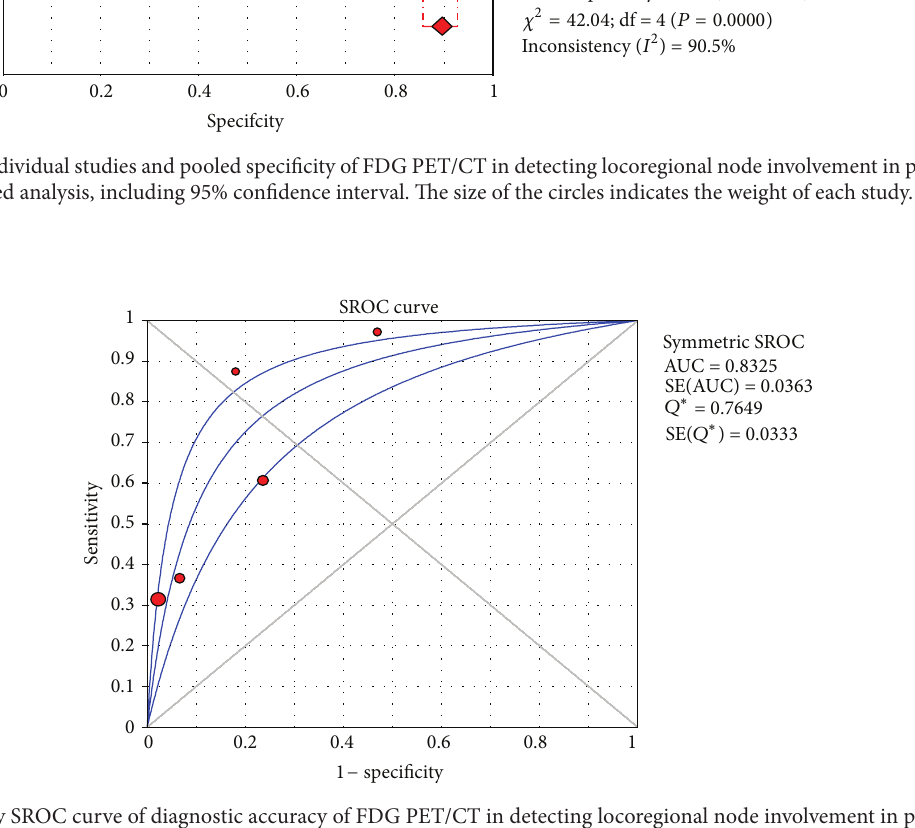
Figure 4: Summary SROC curve of diagnostic accuracy of FDG PET/CT in detecting locoregional node involvement in patients with ACC on a per lesion-based analysis, including 95% confidence